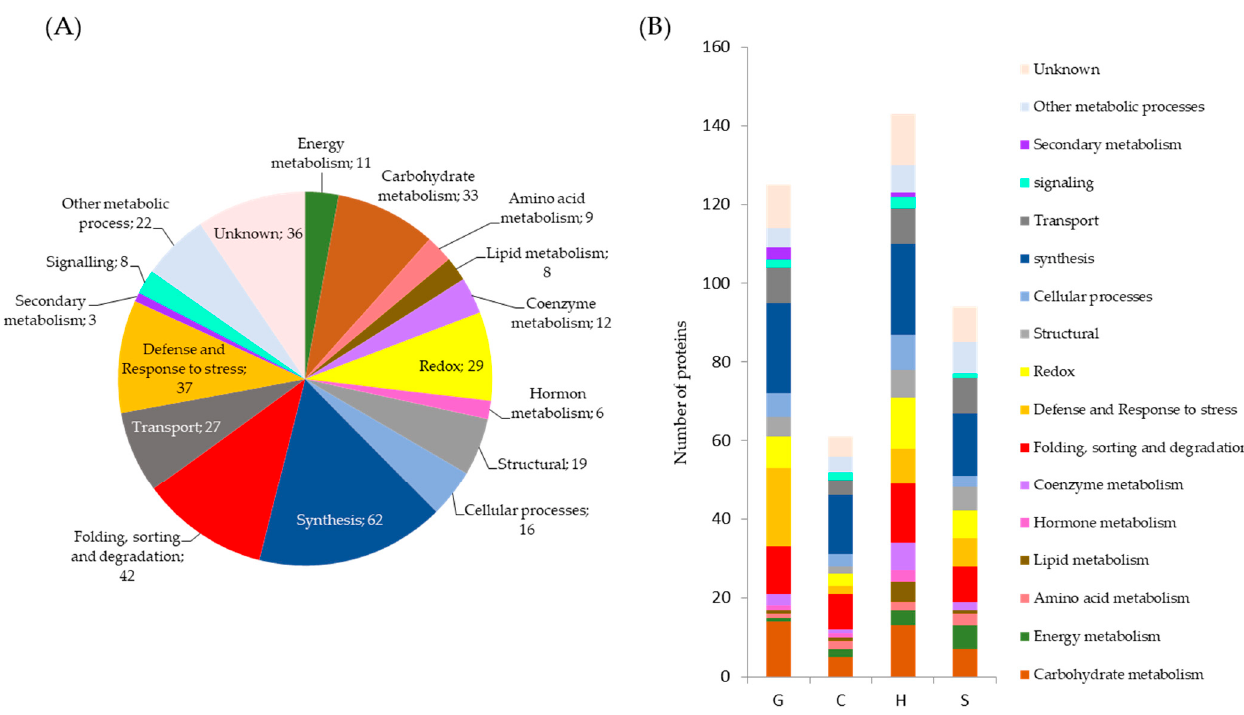
Figure 4. Functional categories of the 380 proteins. Total number of proteins significantly increasing in abundance after drought ( A ) and in each of the populations ( B ): C, Cadiz; G, Granada; H, Huelva; S, Seville.